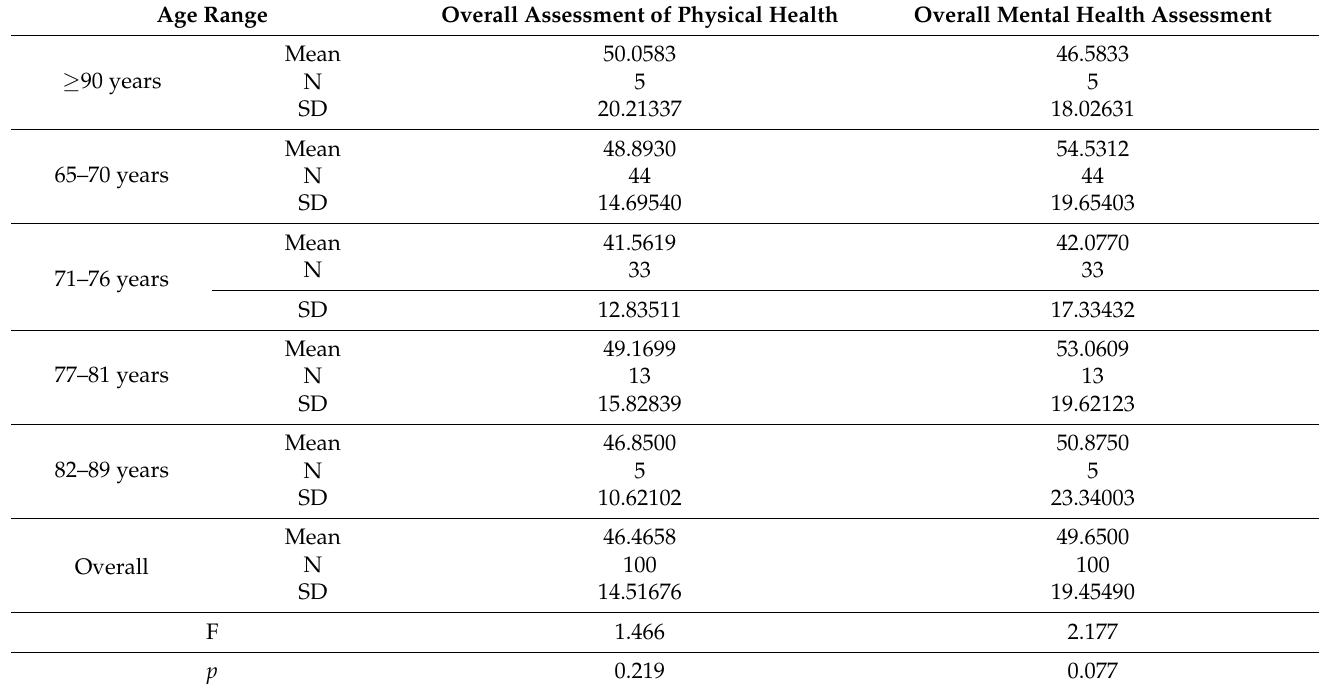
Table 4. Quality of life using the SF-36v2 questionnaire and